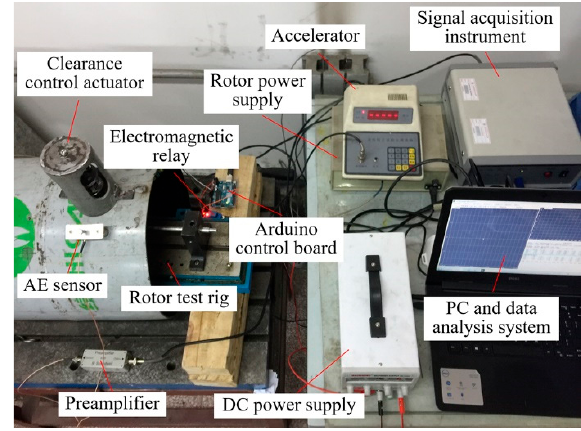
Figure 13. Equipment of the clearance control mechanism.